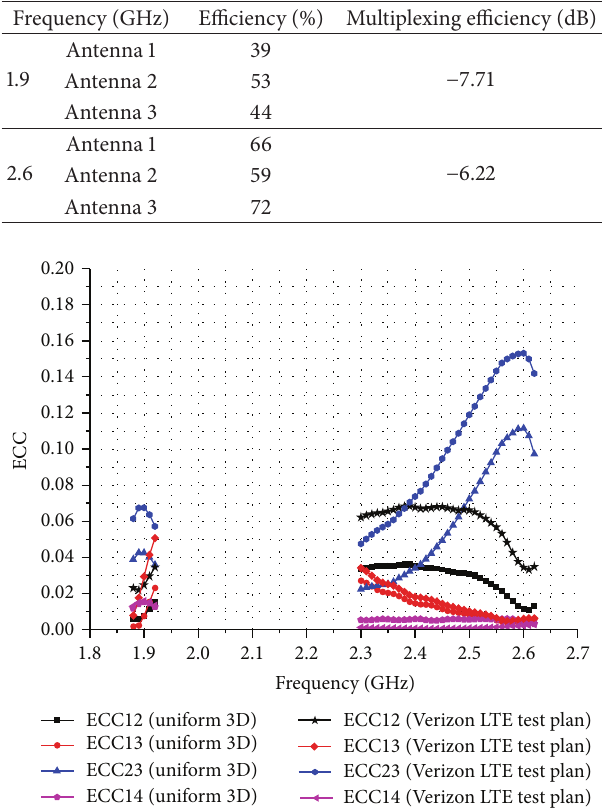
Table 6: Antenna efficiency.